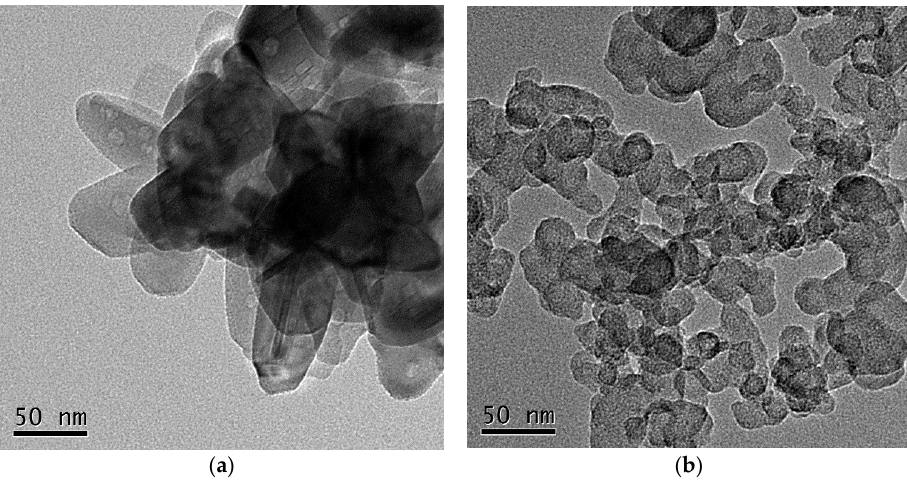
/ C ( b 2 ( a ) and CuNi